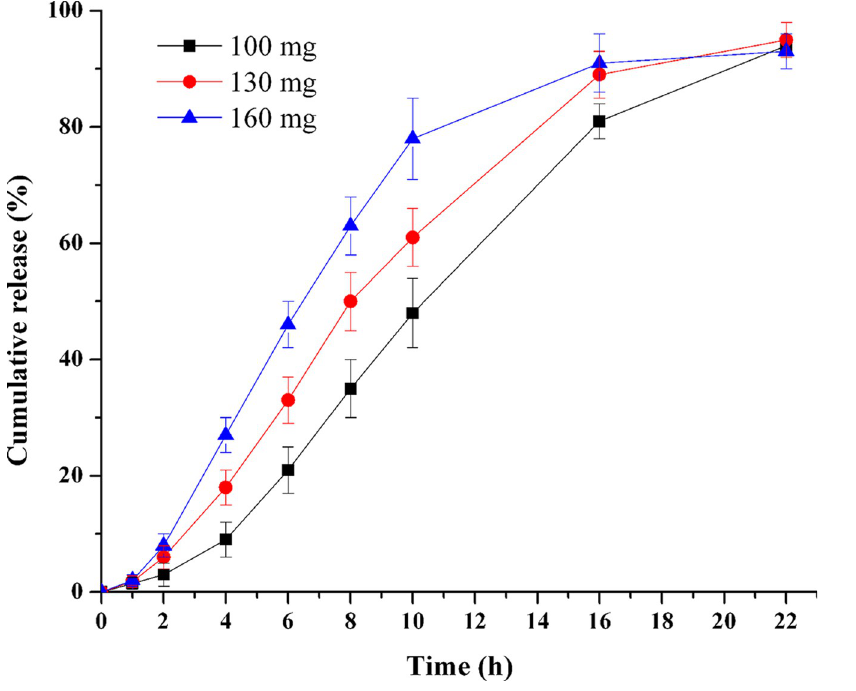
Fig 7. Effect of PEO amount in push layer on TPM release (n = 6).